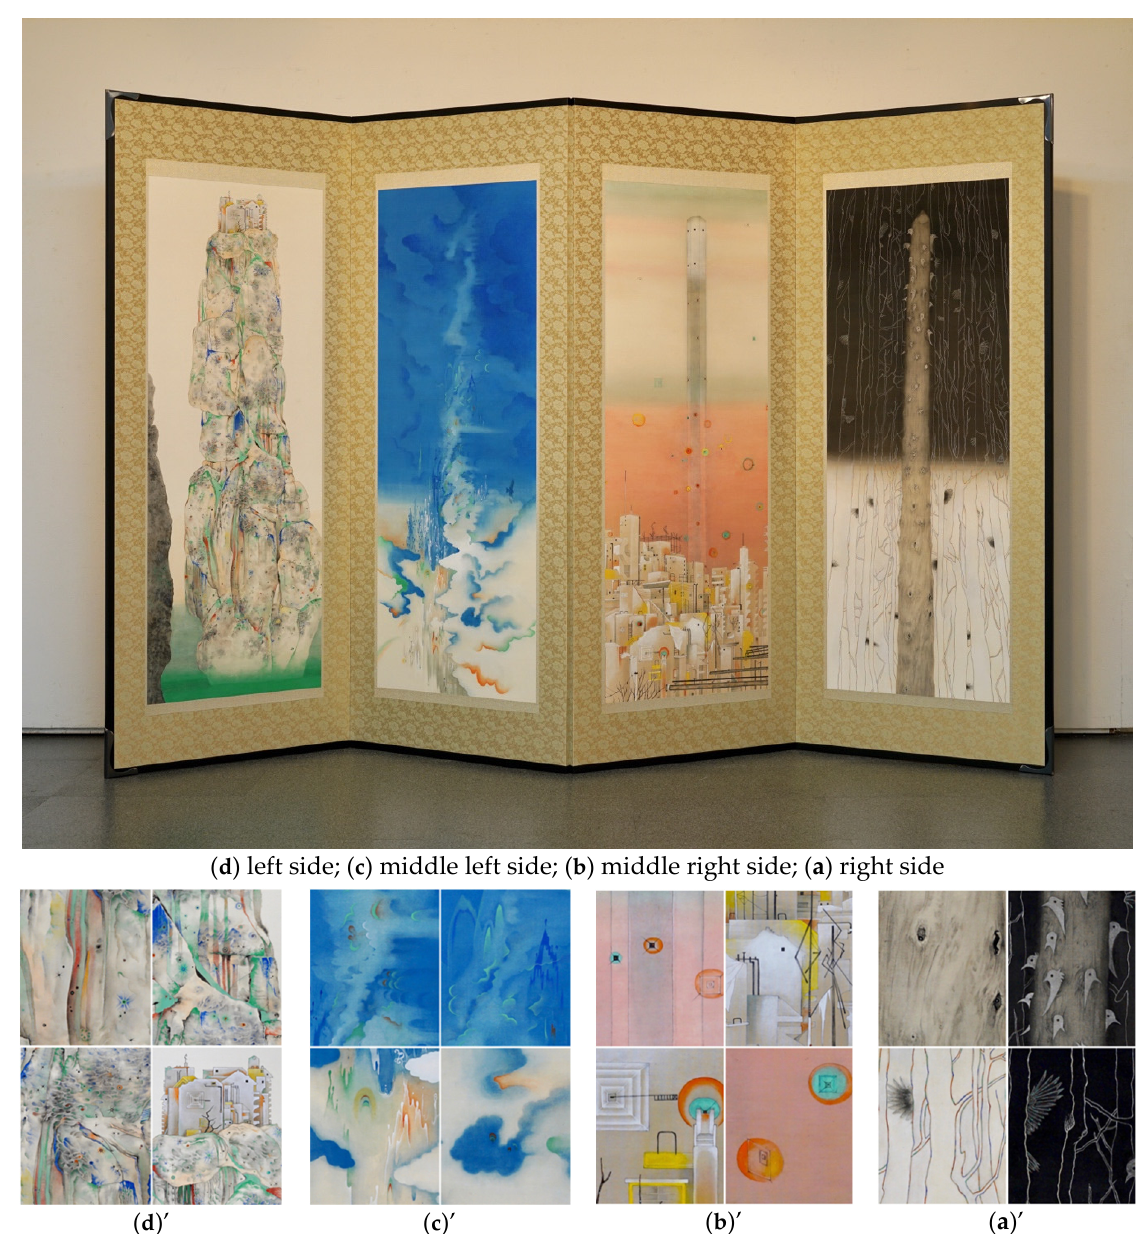
Figure 8. NAKAMURA Kyoko, “ Onbashira Zu-e Screen ”, four-fold screen, color on silk, 185 × 306 cm, 2019, paintings each 145 × 55.5 cm, ( a ) left side: pillar of the shrine forest, ( b ) middle left side: pillar of the city, ( c ) middle right side: pillar of the ghost, and ( d ) right side: pillar of rocks; ( a )’–( d )’ Detail of each paintings. Since a fold screen is counted its surfaces from right to left, it is denoted (a)–(d) from the right here. Paintings mounted by S ō gad ō , Tokyo, Japan; picture was taken at a gallery Art Space Kimura ASK?, Tokyo, Japan.